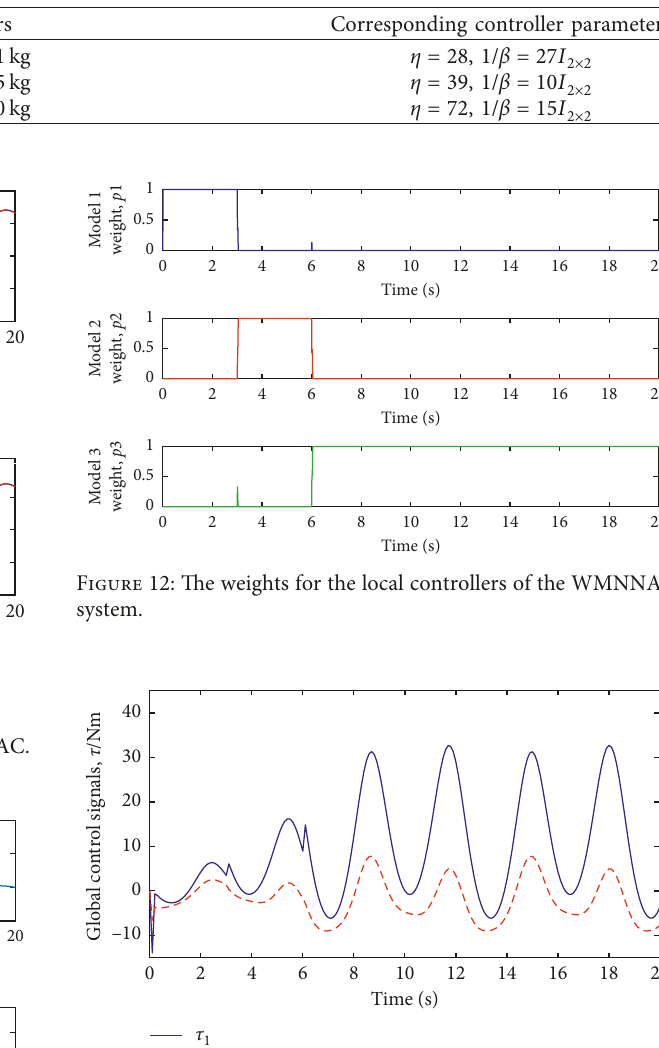
Table 1: The designed parameters of the model set and the controller set.